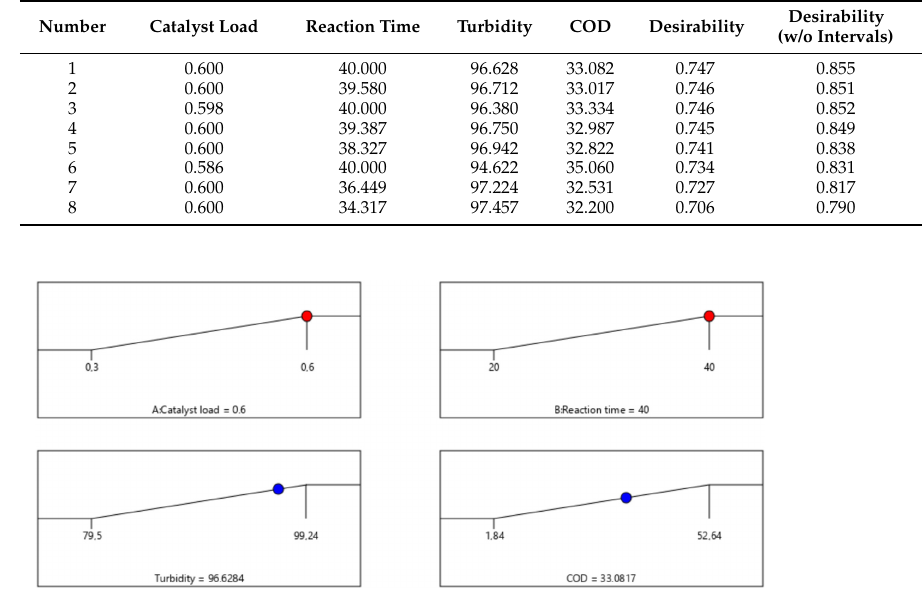
Figure 7. Selected numerical optimized condition ramp plots.